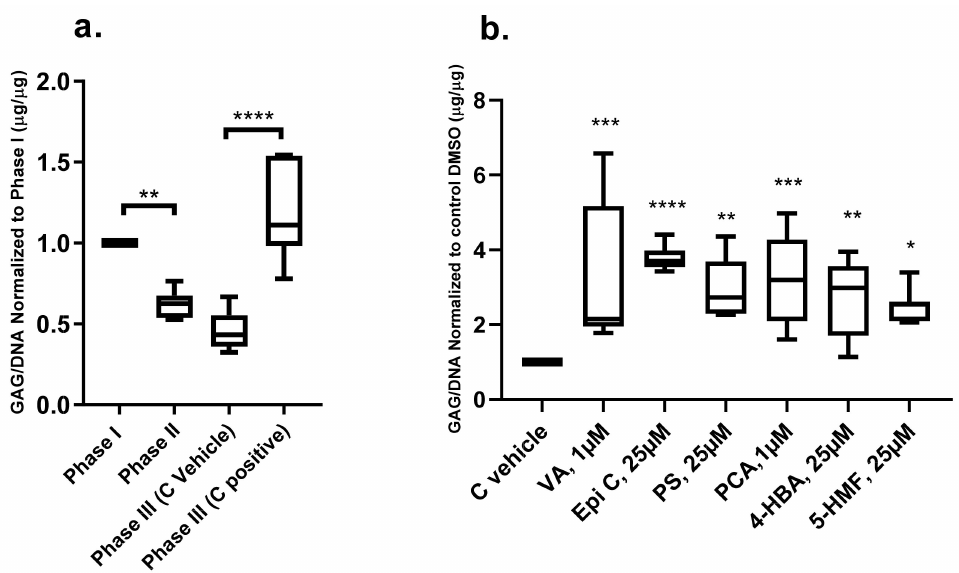
Figure 3. Biochemical analysis of the osteoarthritic chondrocyte pellets (long term) in the inflammatory model. a ) GAG production per DNA in three di ff erent phases of the inflammatory model. b ) The e ff ect of TCM compounds on GAG / DNA ratio in human osteoarthritic chondrocytes in phase III after induction of inflammation normalized to control vehicle group (C vehicle). n = 3; n indicates the number of human OA chondrocytes donors; for each donor three experimental replicates were analyzed. For statistical analysis using Graphpad Prism, one-way analysis of variance (ANOVA) followed by Tukey’s post hoc test (multiple comparisons) for Figure 3a and Dunnett’s post hoc test (multiple